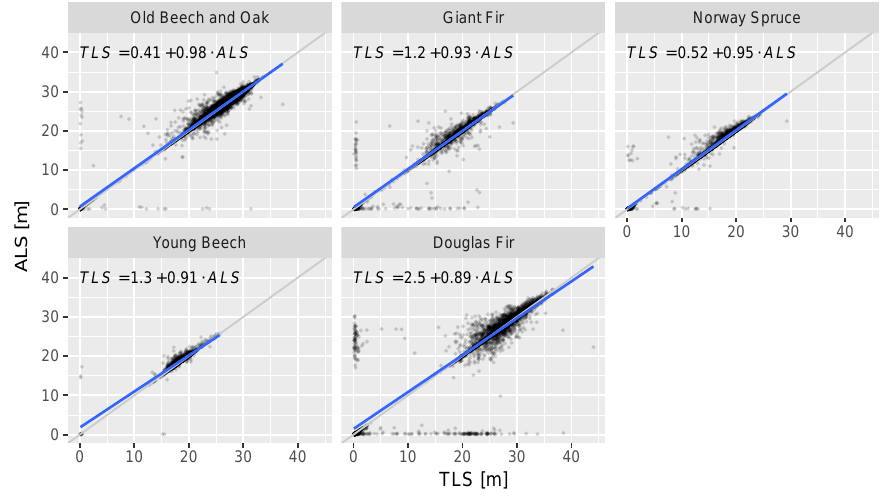
Figure 7. Differences in CHM per plot. Ordinary least squares regression lines in blue and formulas. Grey lines are 1:1 lines. Points are transparent to facilitate identification of high density